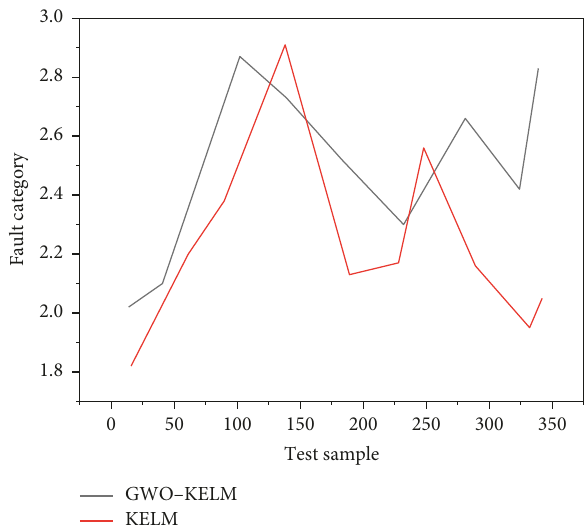
Figure 2: Diagnosis rate of the GWI-KELM method and diagnosis rate of the KELM